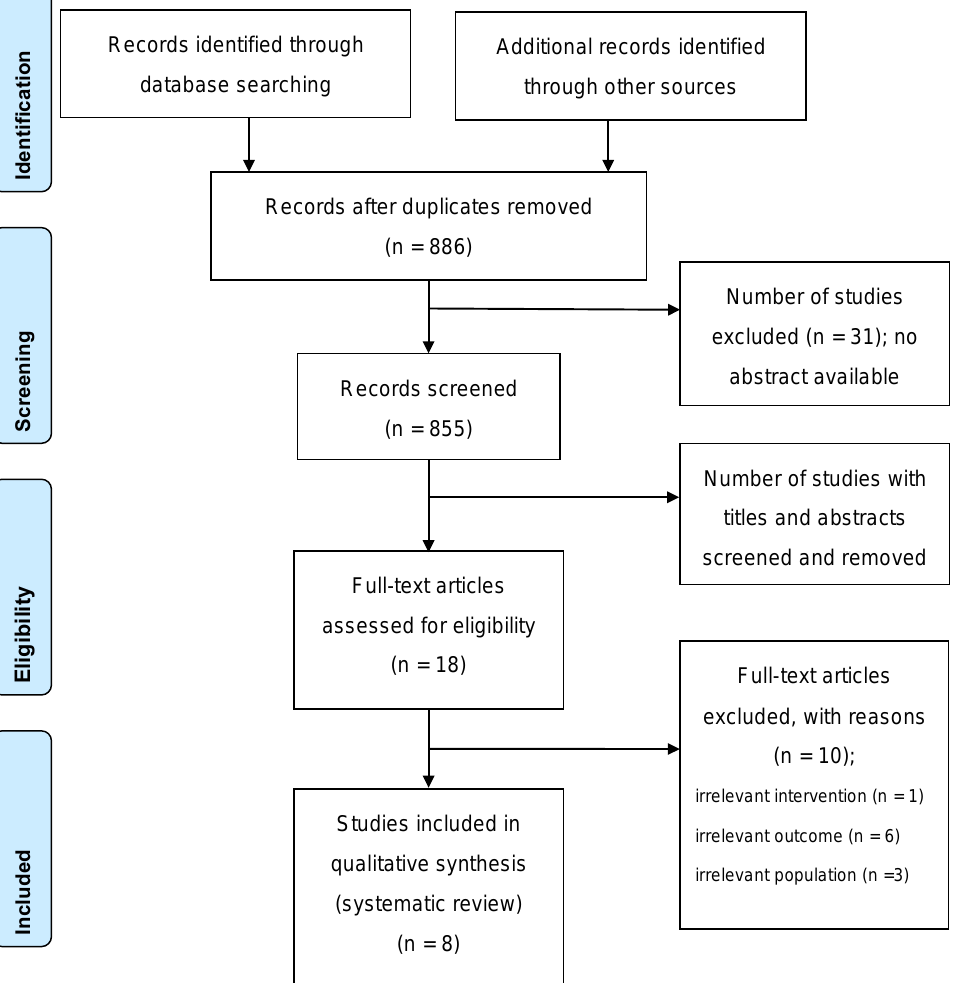
Figure 1. Flow diagram of the systematic literature search. Preferred Reporting Items for Systematic Reviews and Meta-Analyses (PRISMA) flow diagram indicates the number of records identified, included, and excluded through the different phases of a systematic review.